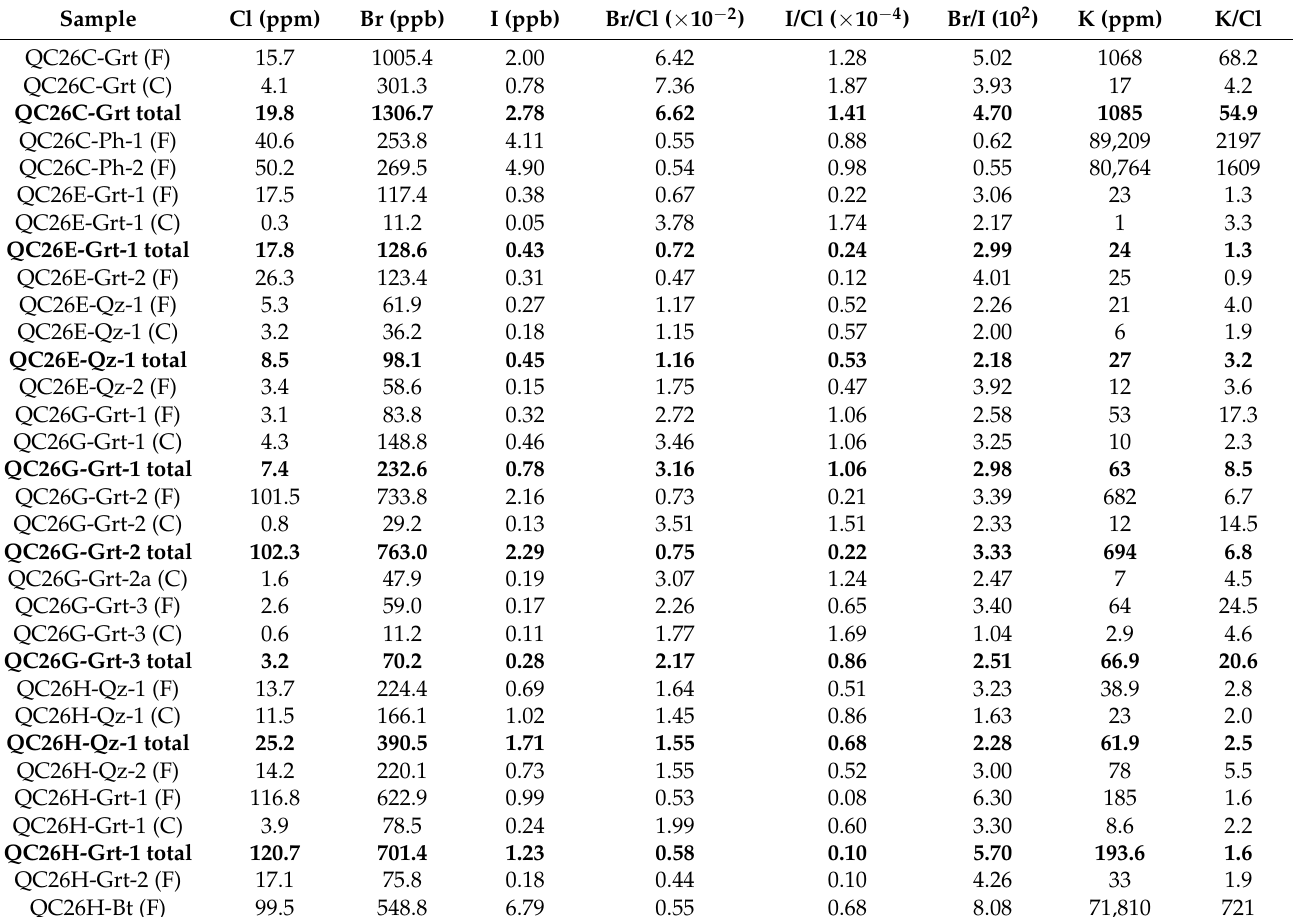
Table 4. Halogen and K abundances and ratios obtained by crushing and heating analyses of Årsheimneset samples (C = crushing; F = fusion).